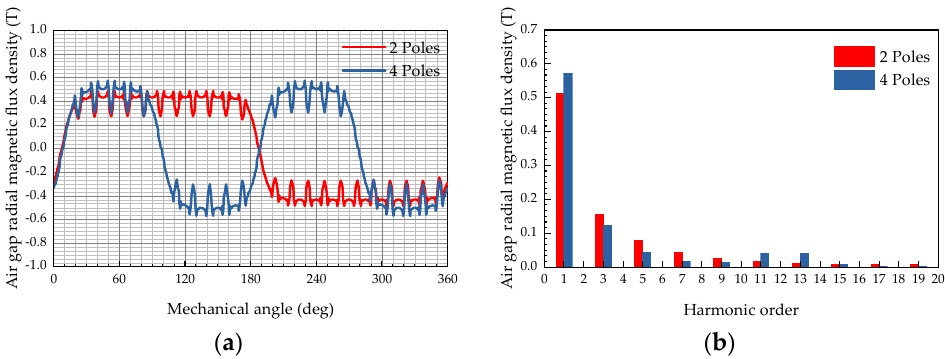
Figure 8. Radial air ‐ gap flux density of two ‐ pole and four − pole motors under no load: ( a ) radial air ‐ gap flux density with mechanical angle; ( b ) Fourier transforms.